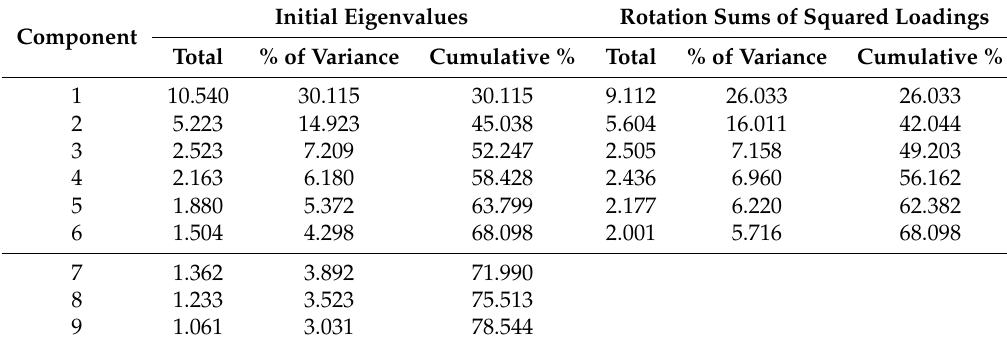
Table 3. Input factors—total variance explained (source: own calculation and elaboration).